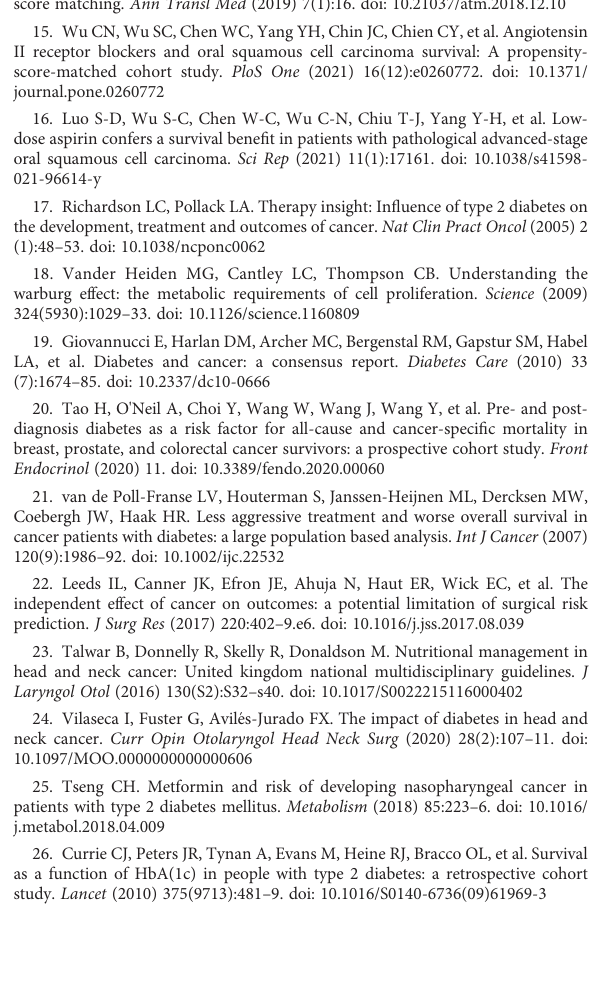
SUPPLEMENTARY FIGURE 1 Kaplan – Meier survival curve for survival rates of different HbA1c intervals at the initial diagnosis of OSCC in patients with DM and without DM. (A) Overall survival; (B) Disease-speci fi c survival. DM, diabetes mellitus. OSCC, oral squamous cell carcinoma. SUPPLEMENTARY FIGURE 2 Kaplan – Meier survival curve for survival rates of different mean HbA1c levels during the whole study period in patients with diabetes mellitus. (A) Overall survival; (B) Disease-speci fi c